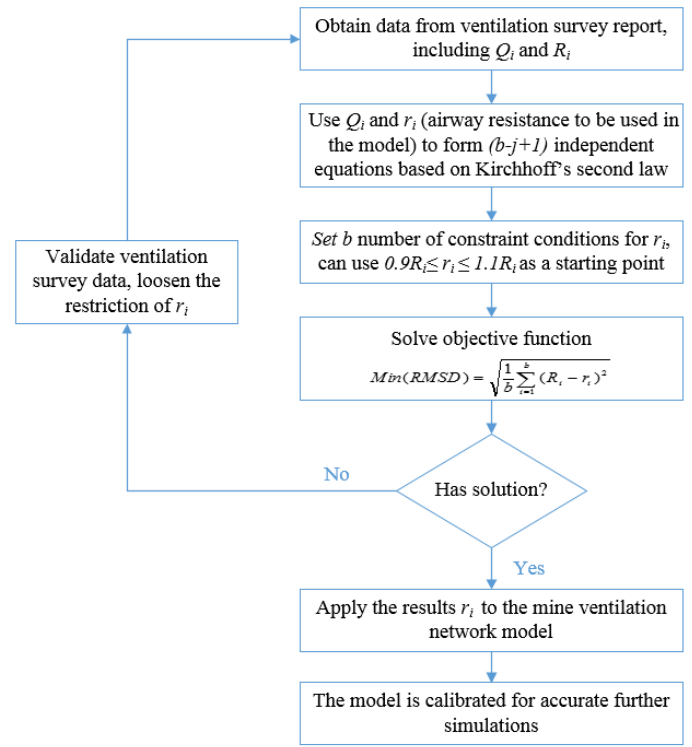
Figure 1. Flowchart of mine ventilation network (MVN) calibration.